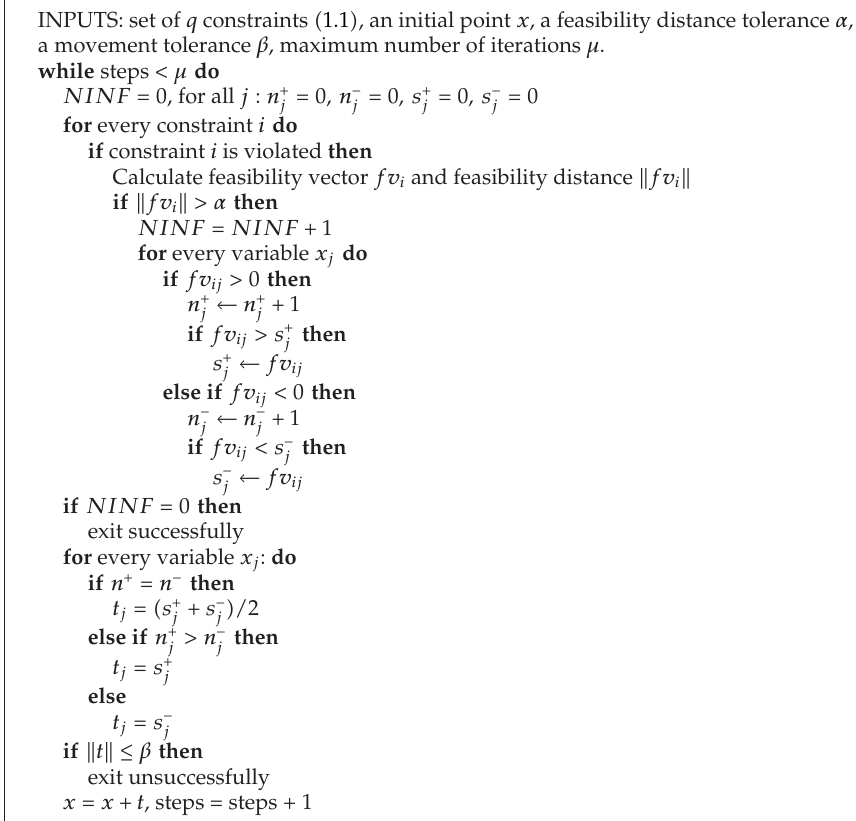
Algorithm 2: DBmax constraint consensus